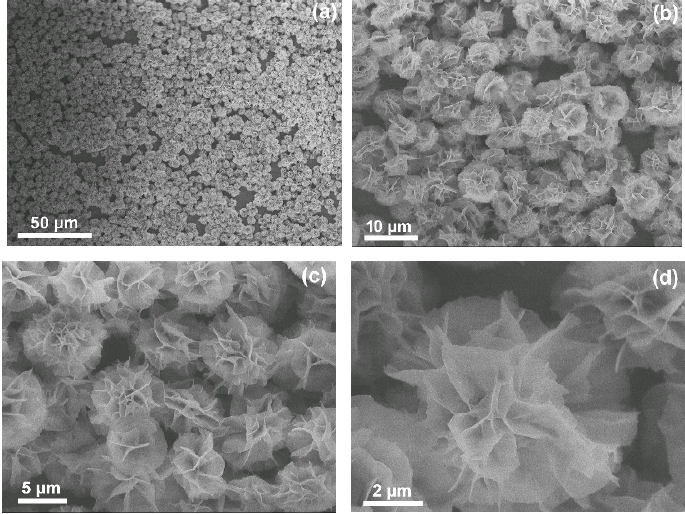
Figure 1. SEM images of the co-immobilized tri-enzymes with different enlargement factors ( a – d ).